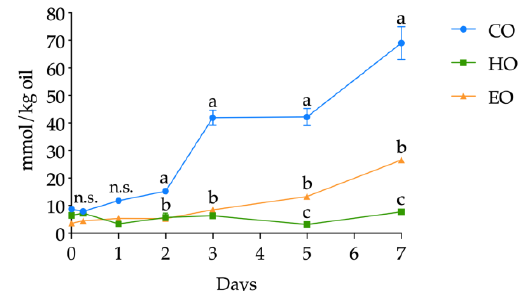
Figure 5. Kinetics of hexanal content (mmol / kg oil) in stripped linseed oil without antioxidants (CO), with hemp extract (HO), and with α -tocopherol (EO) and results of ANOVA with Duncan’s test. Each point represents the mean ± standard deviation of three independent replicates ( n =